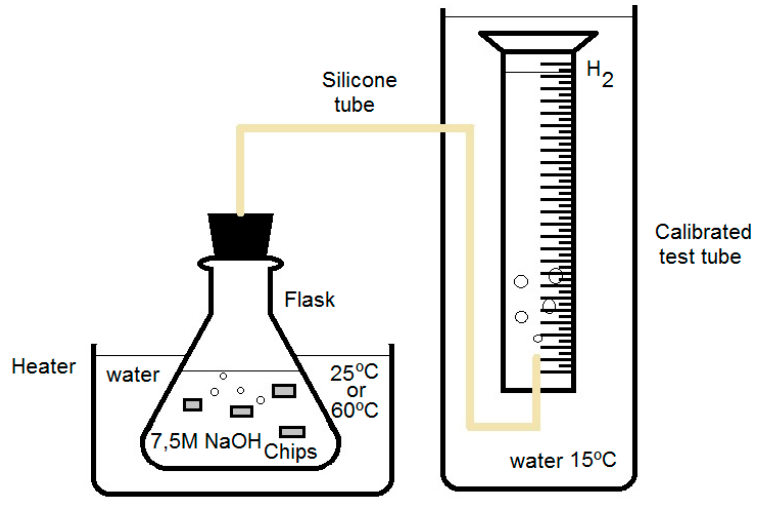
Figure 1. Draft of the experimental equipment used for the theoretical-model-determination test.